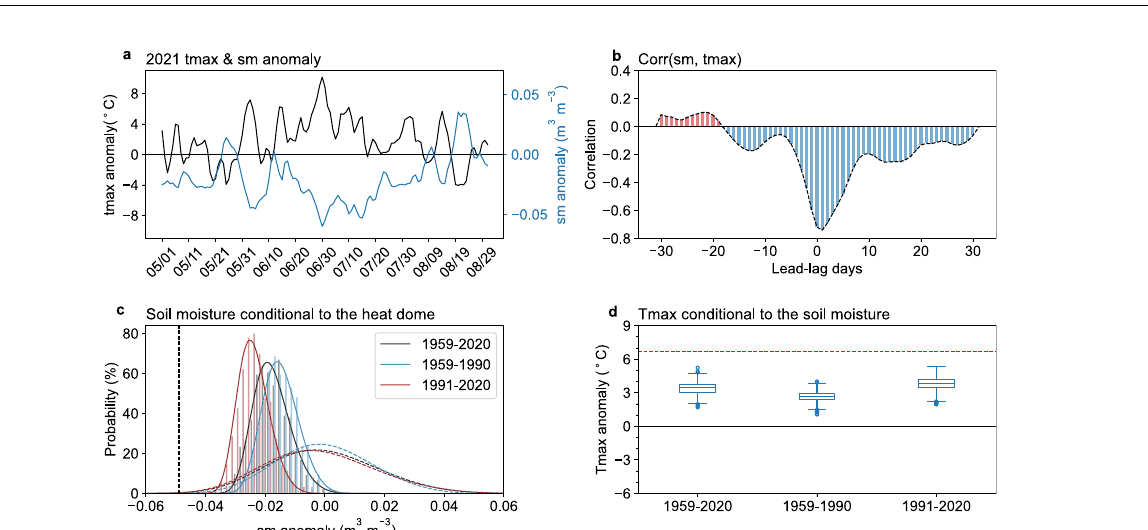
Fig. 4 | The intensities of hot extremes associated with similar heat domes increase faster than global mean temperature. a The distribution of the max- imum temperature anomalies (detrend, unit: °C) for fl ow analog days (analogs, unshaded)generatedusingeddygeopotentialheightanomaliesat500hPafrom27 June – 3 July and randomly picked days (control, shaded) for ERA5 reanalysis and CESM1 simulations. b The distribution of the maximum temperature anomalies